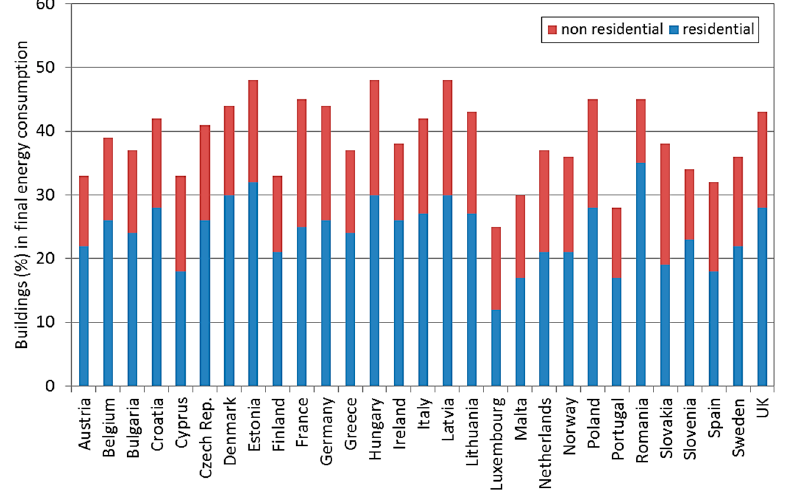
Figure 5. Share of buildings in final energy consumption in Europe. Source [32].